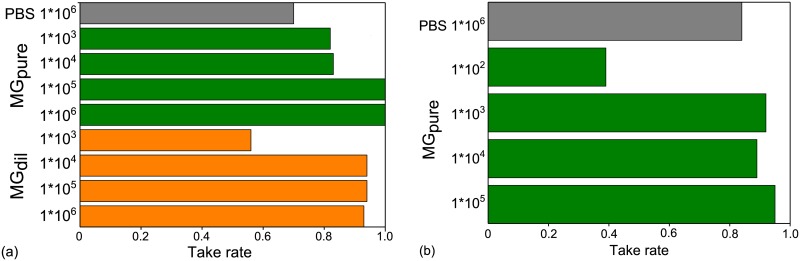
Tumour take rates for both entities.Tumour take rates for (a) HNSCC cell line FaDu and (b) human GBM cell line LN229 after injection of varying cell concentrations in PBS, undiluted MG (MGpure) or a 1:1 dilution of MG and PBS (MGdil). Depicted are the merged results of two and three injections of LN229 and FaDu, respectively, temporally separated by 4–8 weeks.